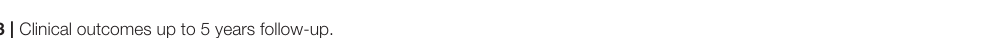
TABLE 3 | Clinical outcomes up to 5 years follow-up. Clinical